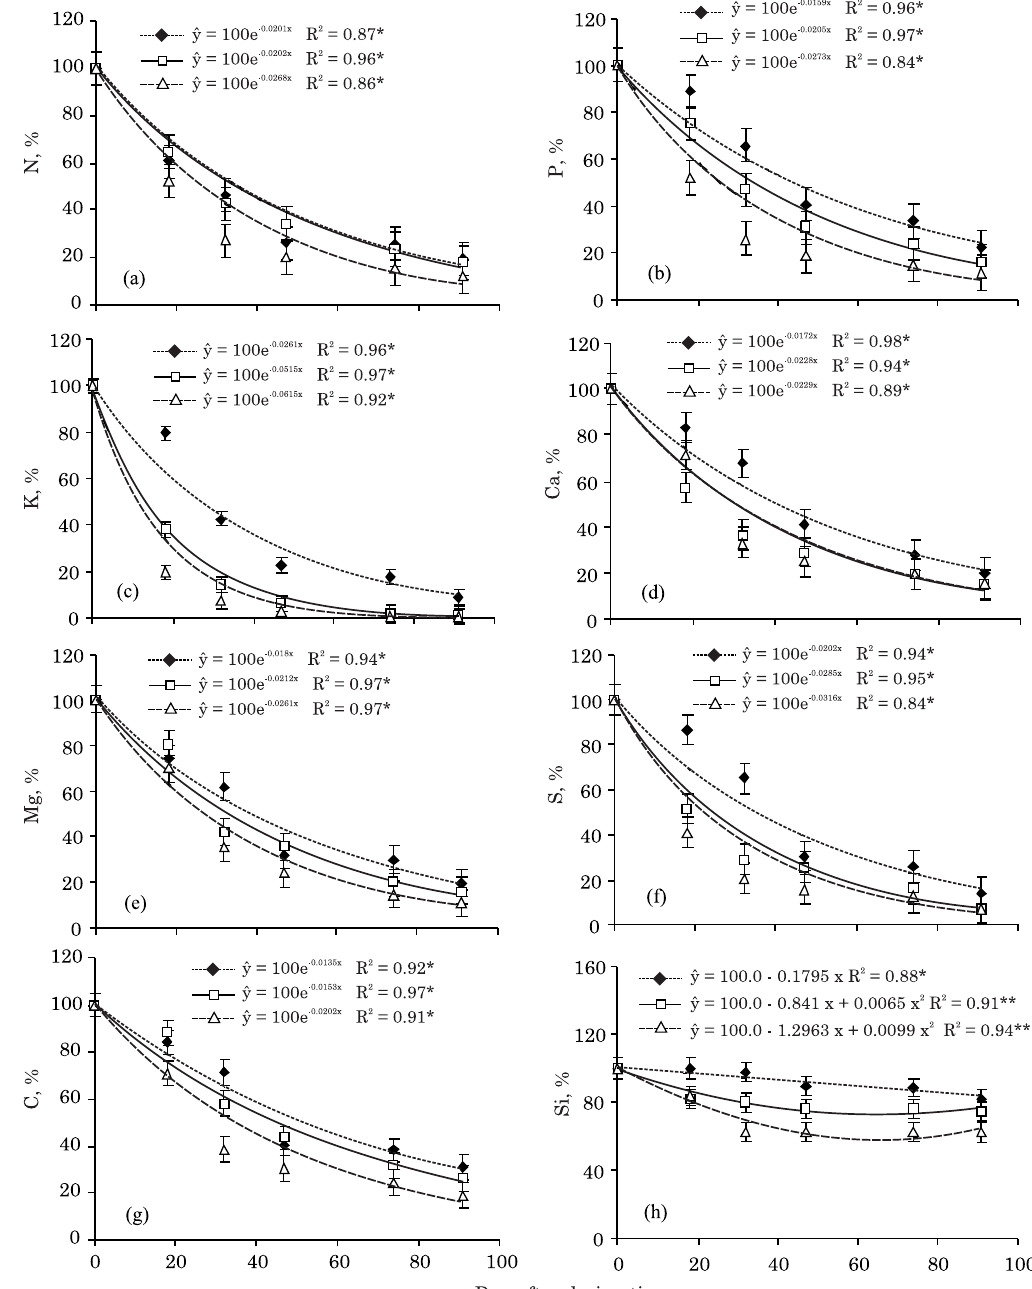
Figure 5. Percentages of N (a), P (b), K (c), Ca (d), Mg (e), S (f), C (g) and Si (h) in pigeonpea ( ), pigeonpea+pearl millet ( ) and pearl millet ( ) shoot dry matter according to time after desiccation.** and * significant at 1 and 5 % by the F test, respectively. Vertical bars indicate the value of LSD at 5 % by the Tukey